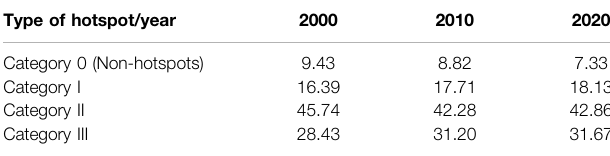
TABLE2| Areaproportionofeachhotspotcategoryin2000,2010,and2020(%). Type of